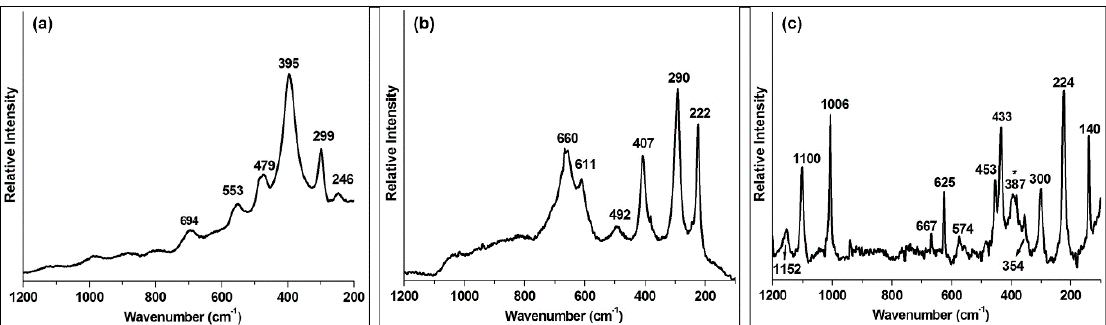
Figure 7. Raman spectra of the 1200–100 cm − 1 range obtained on different iron rich particles on erionite: ( a ) goethite, ( b ) hematite, and ( c ) jarosite. The band indicated by * in ( c ) may be ascribed to goethite.